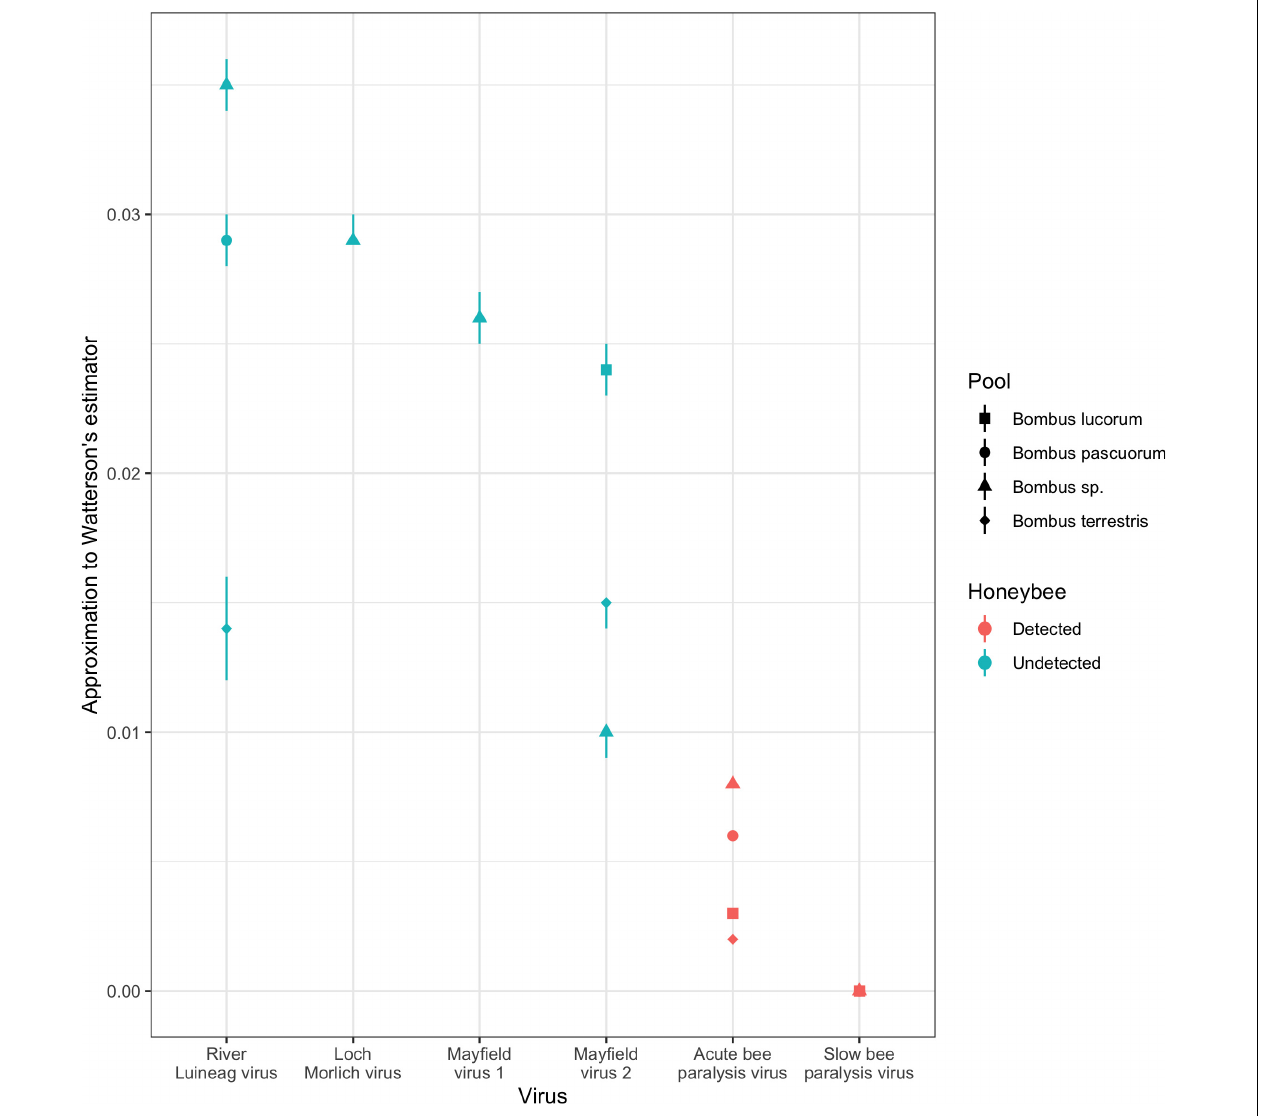
FIGURE 2 | The diversity of Acute bee paralysis virus, Loch Morlich virus, Mayfield virus 1, Mayfield virus 2, River Luinaeg virus and Slow bee paralysis virus in a series of metatranscriptomic pools as measured by an approximation to Watterson’s estimator (see section “Materials and Methods”). The viruses are ordered from highest to lowest diversity in the mixed Bombus pool, the only pool for which all combinations were assayed. Errors correspond to estimation at the end points 90% credible interval for the number of extra untested positives from the pools (see section “Materials and Methods”). Combinations were excluded if the median read depth over called differences from the consensus was less than